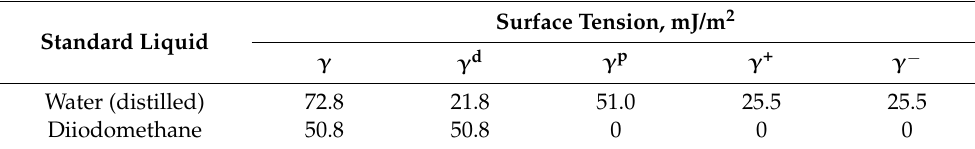
Table 5. Characteristic of standard liquids.